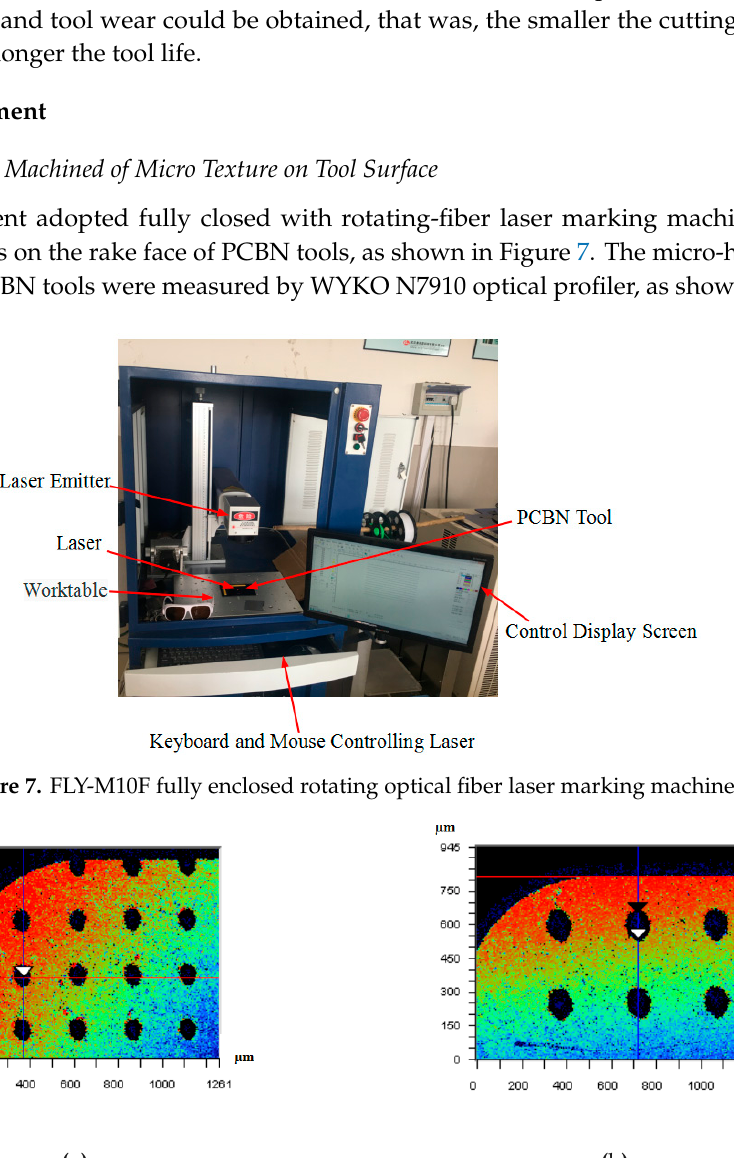
Figure 8. Morphology of micro-hole textures: ( a ) d = 80 µm micro-hole; ( b ) d = 120 µm micro-hole.